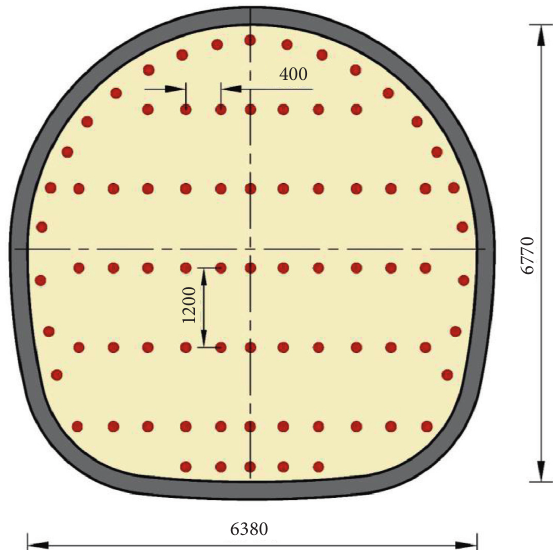
Figure 8: Grouting holes distribution after adjustment